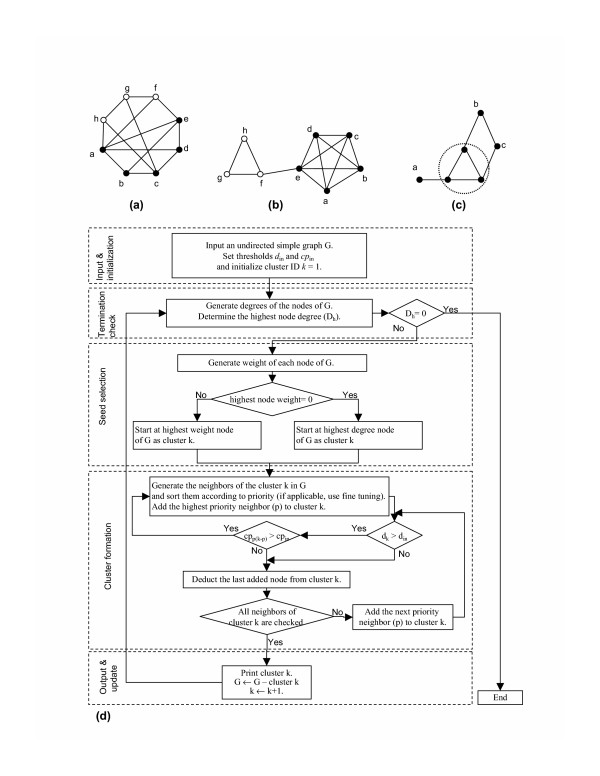
Concepts of the proposed method. (a) and (b) Two typical graphs of the same size and density. (c) A typical cluster and its neighbors. (d) Flow-chart of the proposed algorithm.